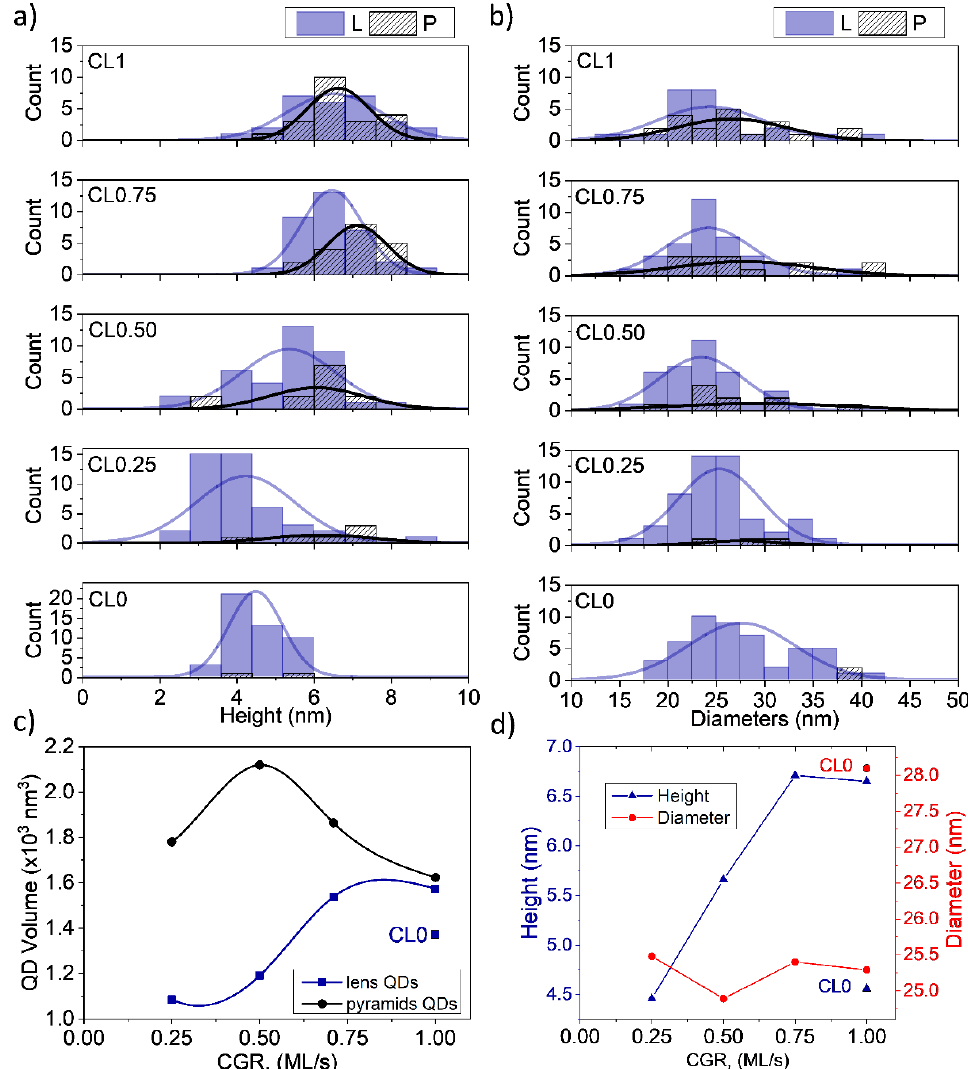
Figure 3. Histograms of ( a ) QD height and ( b ) base diameter distributions for lens and truncated pyramidal geometries of the different QD layers. The differences in the distribution between the two geometries become smaller as the CGR increased. Arrows show the position of the mean values of lenticular (red) and pyramidal (black) QDs. ( c ) The volume of QDs for lenticular and truncated pyramidal-shaped QDs versus CGR. Both geometries show similar average volume for the fastest CGR. ( d ) Average height and diameter of QDs versus CGR. The sample without CL of AlAs (CL0) is not connected by lines.